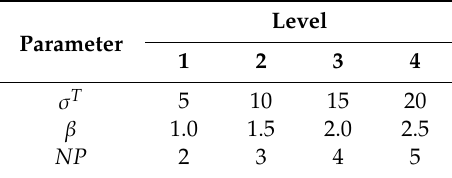
Table 1. Level of each parameter.